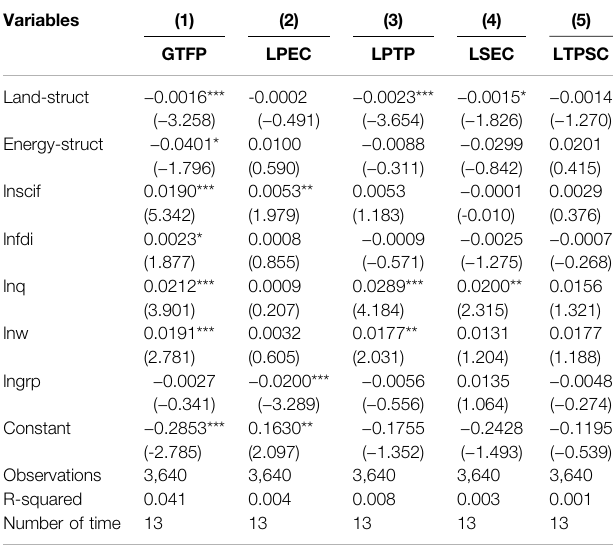
TABLE 6 | Analysis of factors in fl uencing the growth of green total factor productivity.